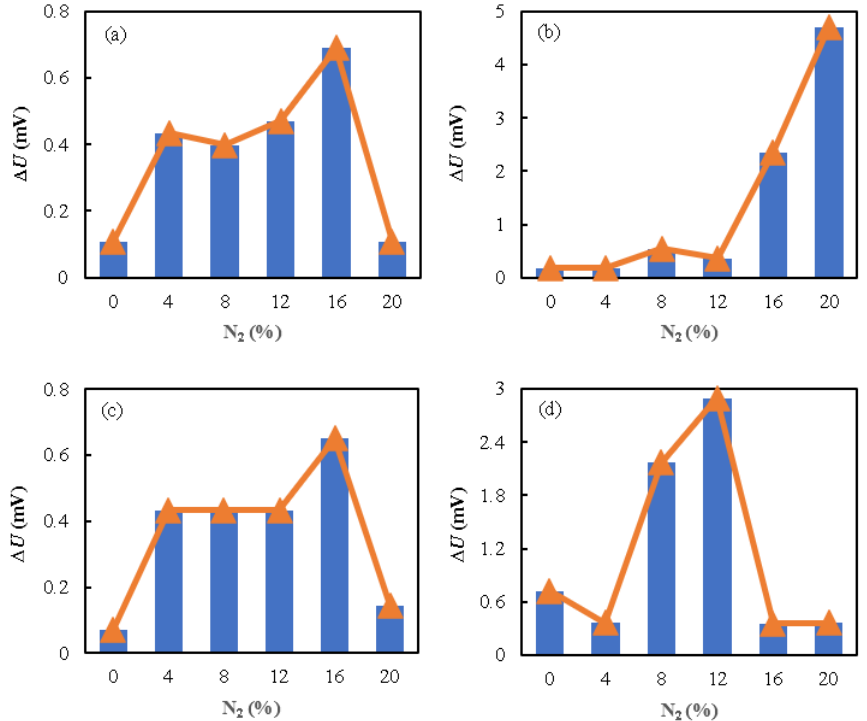
Figure 8. Error analysis of cell 11 with different nitrogen concentrations at different current densities: ( a ) 0.2 A · cm − 2 ; ( b ) 0.6 A · cm − 2 ; ( c ) 1.0 A · cm − 2 ; ( d ) 1.4 A · cm − 2